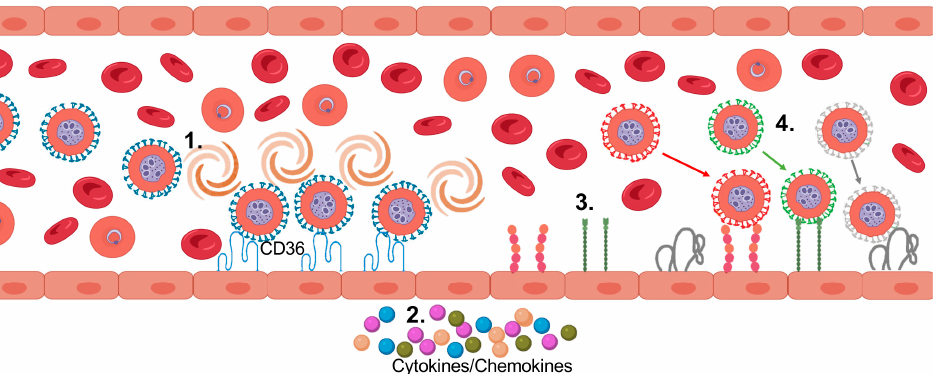
Figure 3. Presumed sequence of sequestration of Pf IEs to the vascular endothelium. 1. Adhesion and rolling over CD36. 2. Over time: endothelial activation, cytokine release. 3. Cytokine/chemokine-induced presentation of various receptors (e.g., ICAM-1, P-selectin, CD9). 4. Adhesion of Pf EMP1s with different binding phenotypes (created with BioRender).